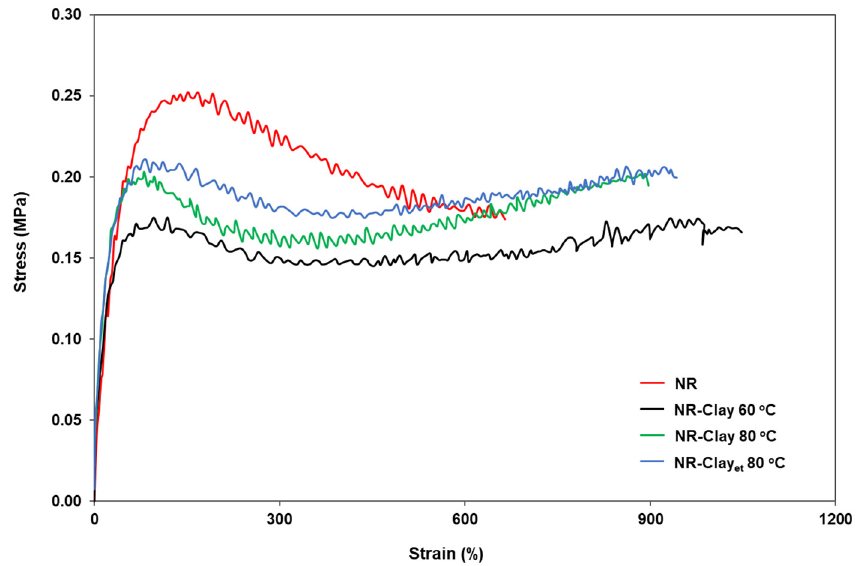
Figure 4. Stress-strain curve of NR, NR-Clay composites at various mixing temperature (60 °C, 80 °C) and NR-Clay composites using Et-OH dispersed bentonite clay.